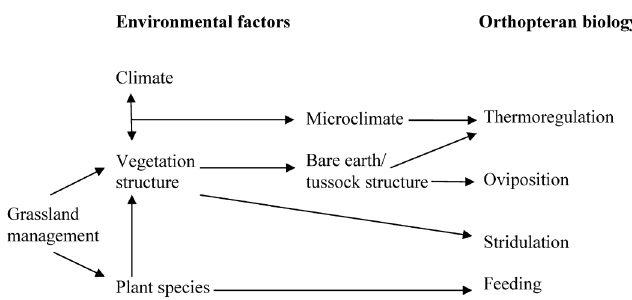
Fig. 2. Relationships between environmental parameters and the main behavioral activities of Orthoptera in a grassland sward (af- ter Gardiner